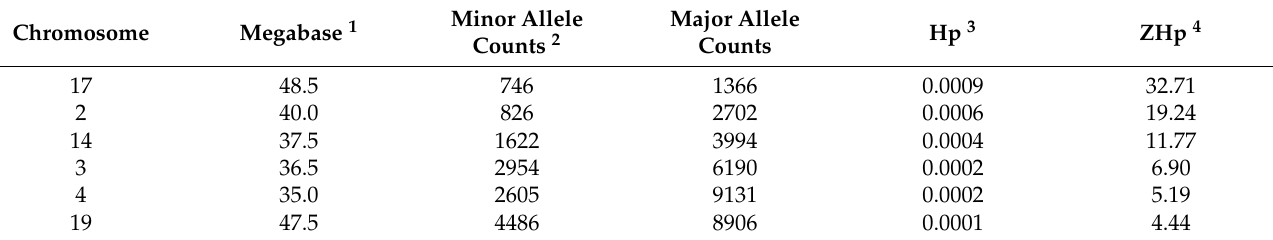
Figure 6. Mean pooled heterozygosity (Hp) values for 0.5 megabase windows with a 50% overlap for ( A ). All individuals ( B ). Females only. ( C ). Males only. Table 3. Pooled heterozygosity values for individuals from